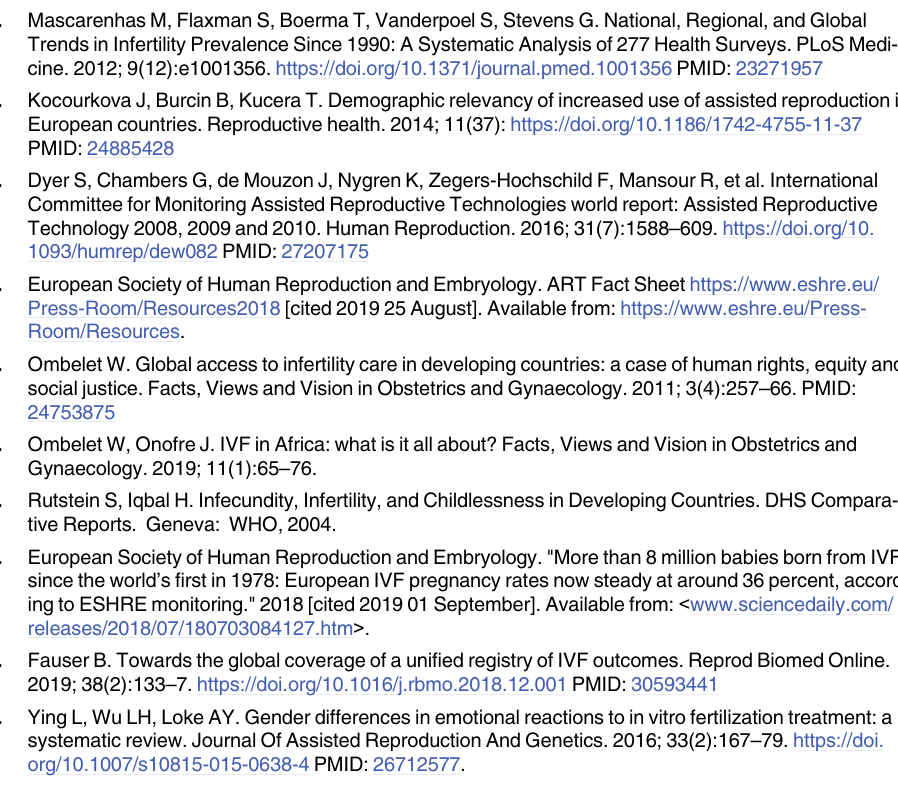
S1 Table. Systematic review search strategy. S2 Table. Information to be extracted from eligible studies. S3 Table. Characteristics of studies included in the review. S4 Table. Methodological quality and risk of bias assessment